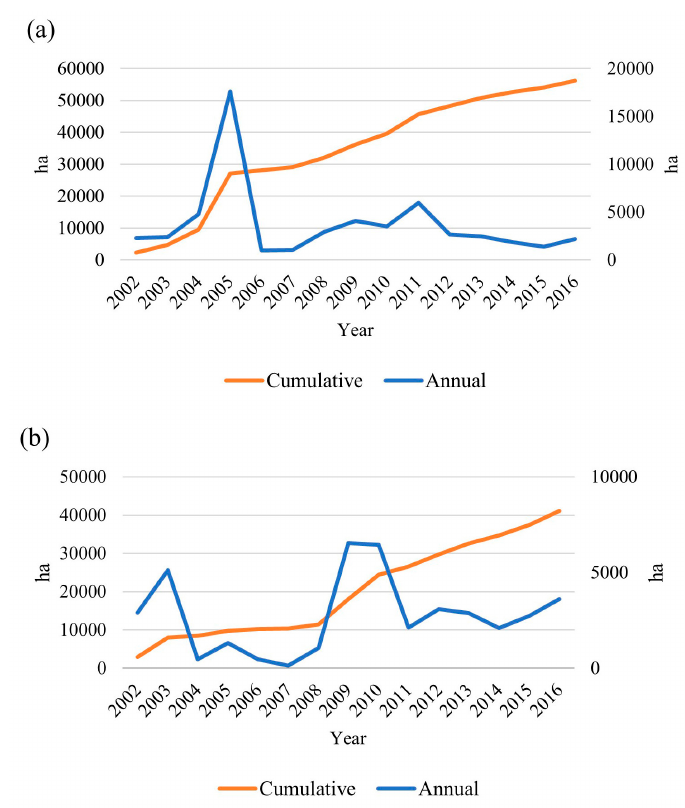
Figure 11. Annual (right y-axis) and cumulative (left y-axis) areas of government-funded afforestation and conservation efforts from 2002 to 2016 in: ( a ) Nandong; and ( b ) Xiaojiang watersheds.